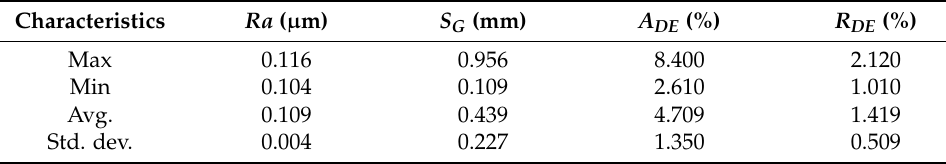
Table 3. Response